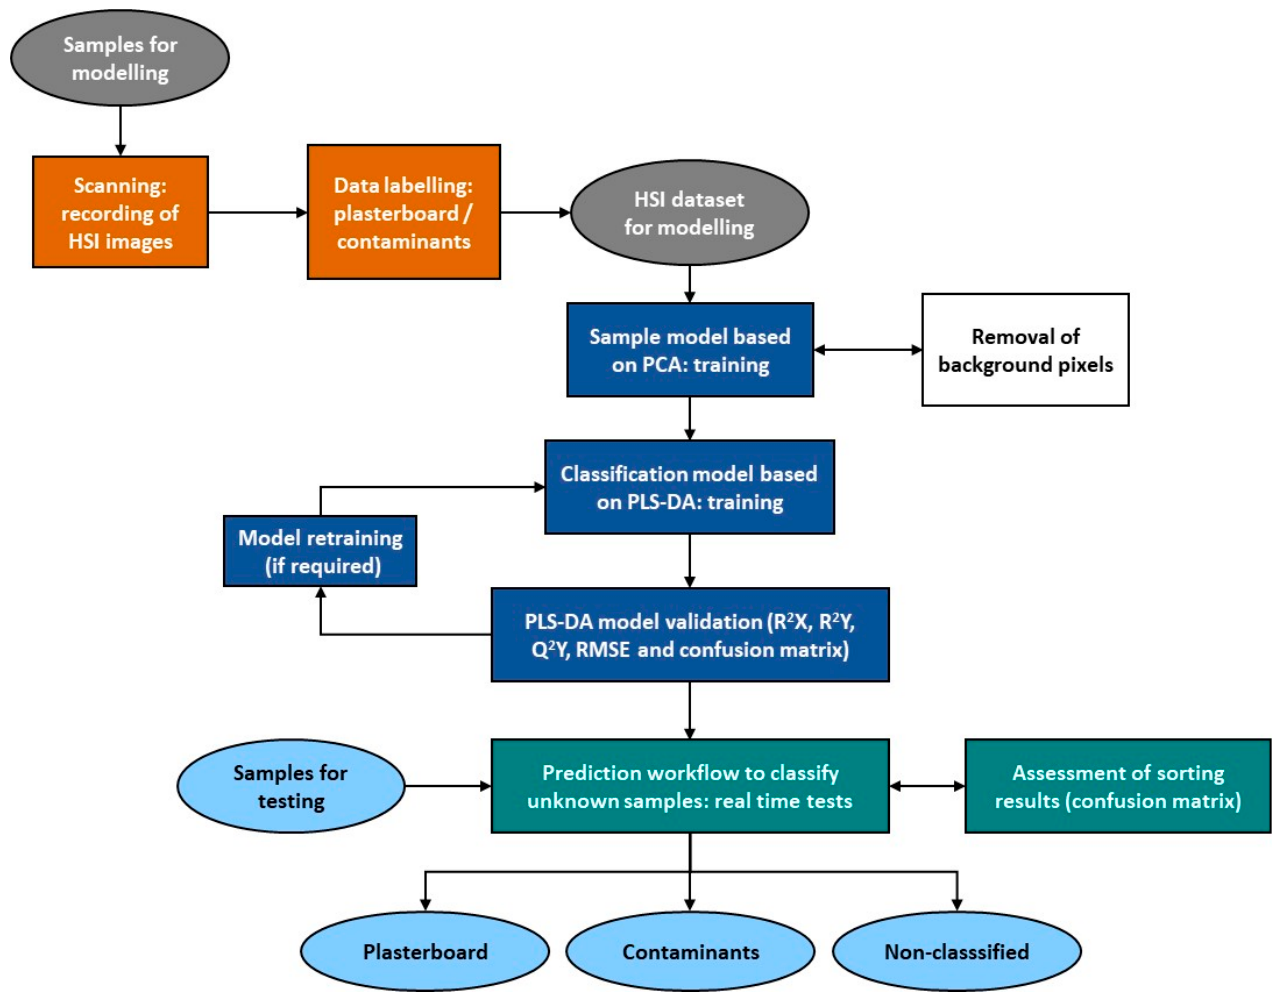
Figure 3. Scheme of the HSI methodology.